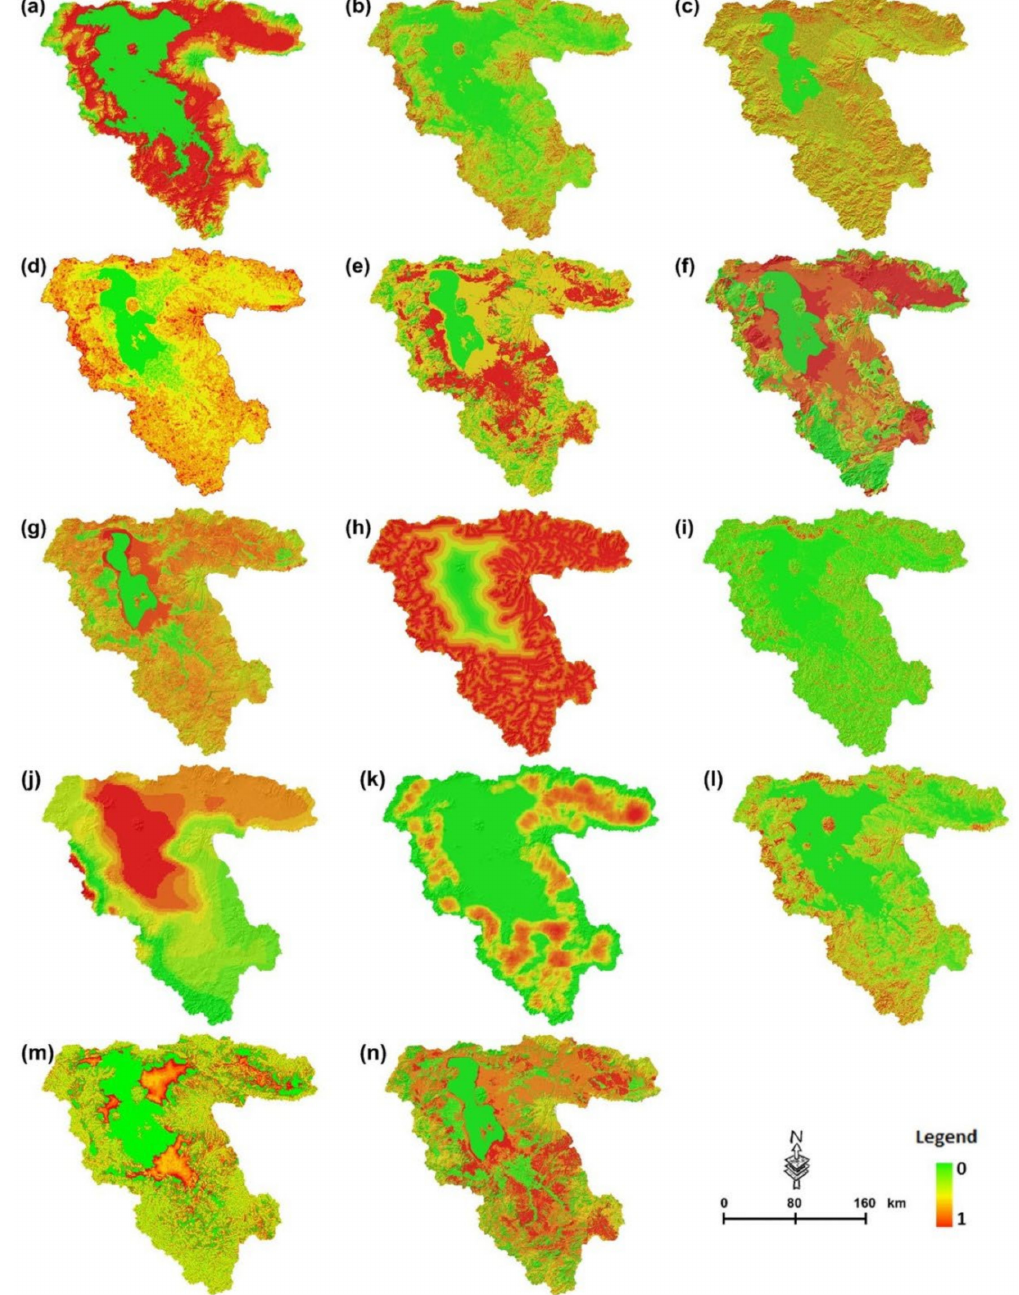
Figure 4. Standardized soil degradation map showing: ( a ) elevation; ( b ) slope degree; ( c ) slope aspect; ( d ) curvature; ( e ) soil depth; ( f ) soil texture; ( g ) vegetation density; ( h ) distance from river; ( i ) Stream Power Index; ( j ) annual precipitation; ( k ) drainage density; ( l ) slope length; ( m ) topographic wetness index; and ( n )